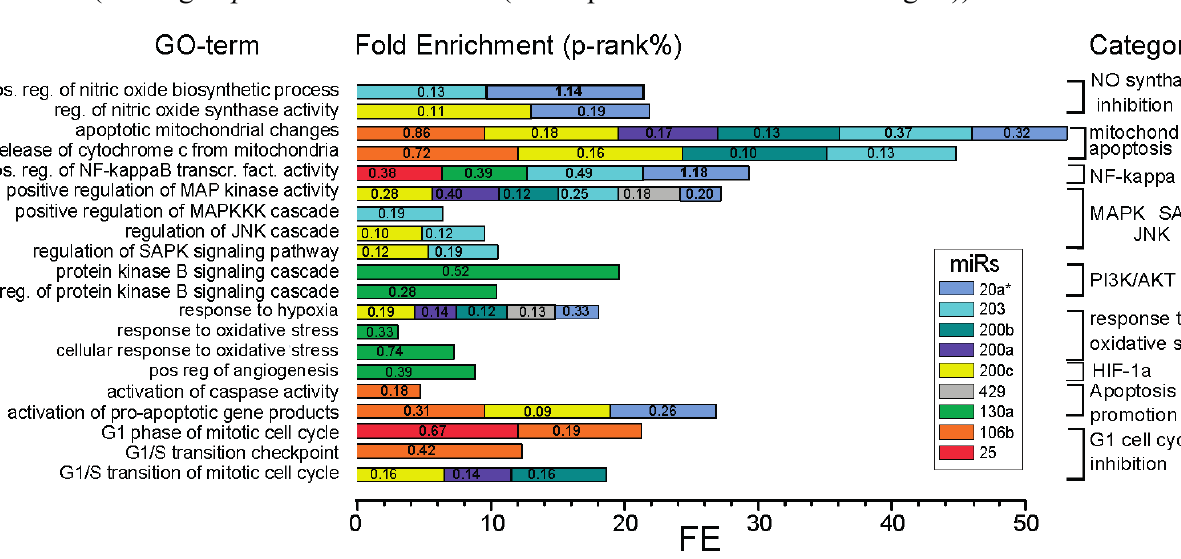
Figure 4. Comparison of PDT-relevant GO terms with enriched miR targets following in silico prediction. Predicted and validated targets of eight significant miRs are enriched in PDT relevant GO terms using the DAVID functional chart annotation tool ( p -rank%: 10/(ranking of p -value of GO term × (100/n predicted and validates